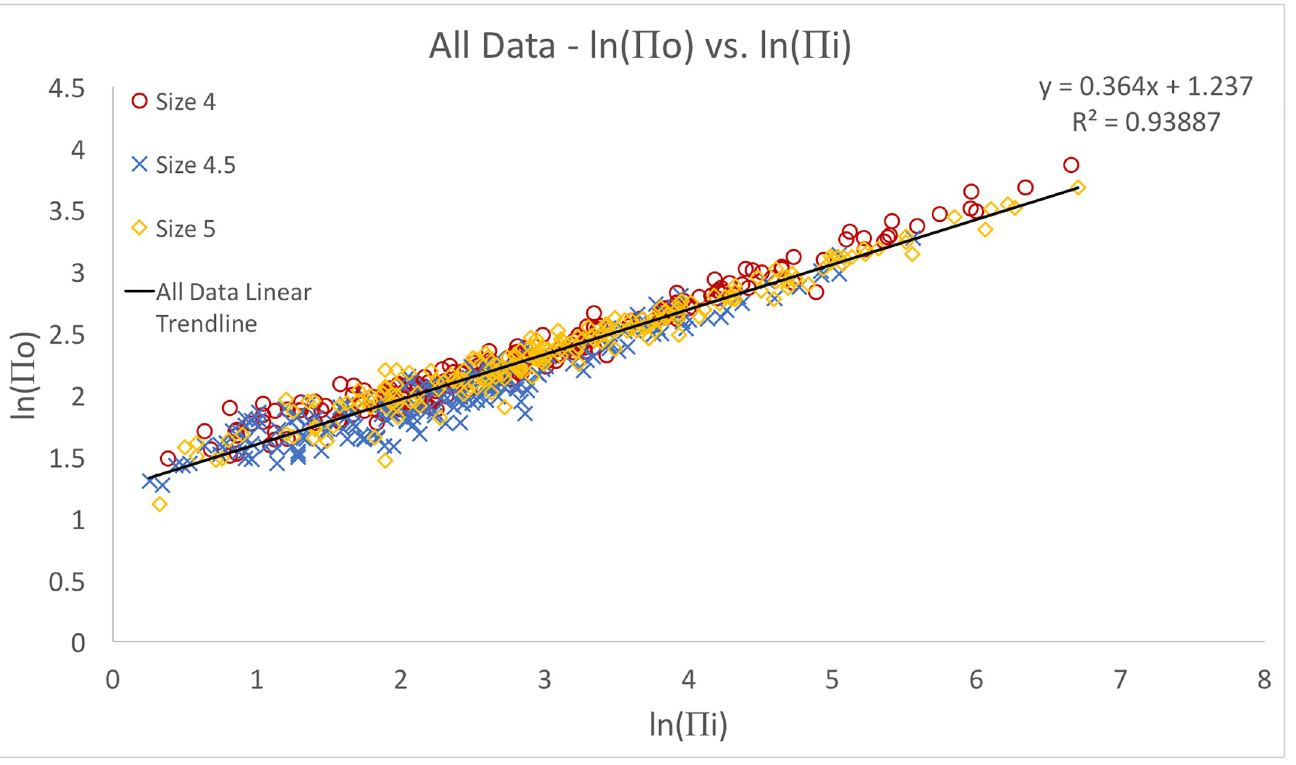
Fig 3. Natural log of P o (Force) versus P i of all 600 data points. A distinct linear relationship suggests all necessary parameters have been considered and all soccer balls follow the same theoretical peak force relationship.